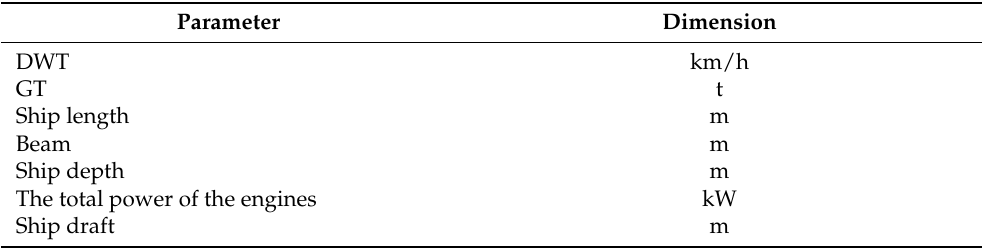
Table 1. Ship technical data collection.